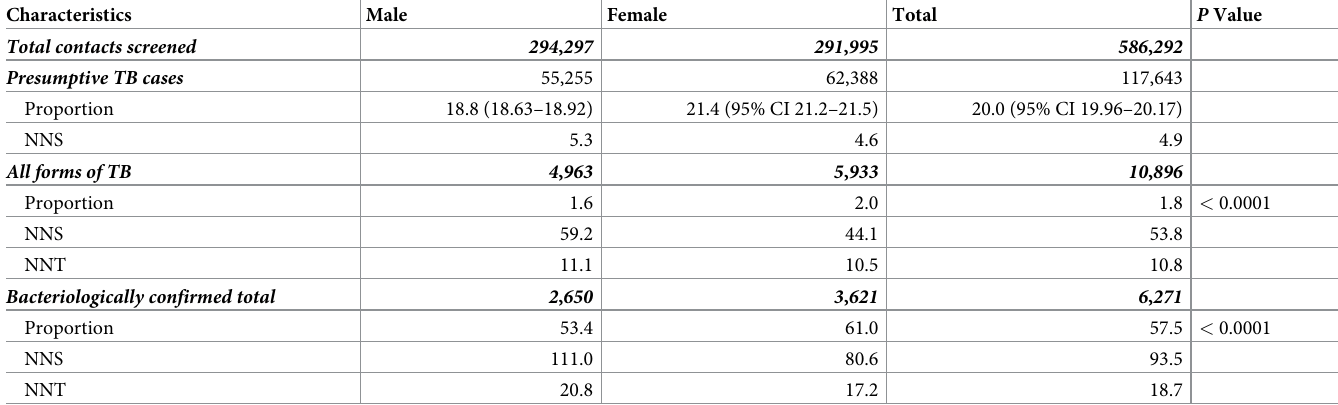
Table 3. Yield of contact screening by sex.